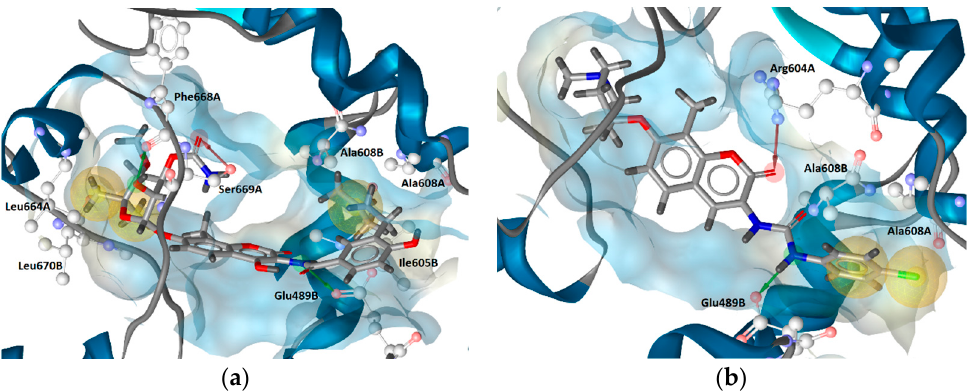
Figure 5. Prioritized docked poses of ( a ) novobiocin and ( b ) compound 2 in a predicted putative allosteric pocket in the Hsp90 β C-terminal domain derived from the cryo-EM structure (PDB Code: 5FWK). For clarity, only amino acids interacting with respective compounds are shown. Hydrophobic features are shown as yellow spheres, H-bond donor as green arrow and H-bond acceptor as red arrow indicating a defined direction for H-bonding. The prioritized poses were used as starting points for molecular dynamics-based (MD) simulations.